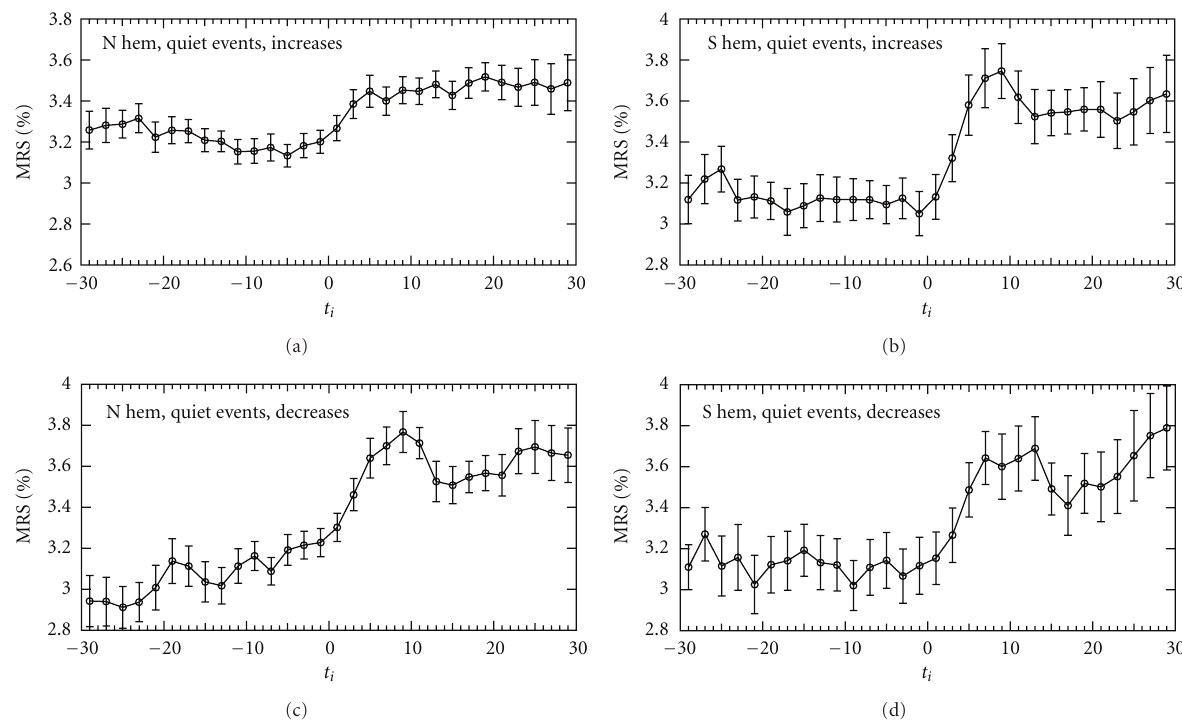
Figure 1: MRS as a function of the scan time, t i , for Quiet events: (a) NH Is; (b) SH Is; (c) NH Ds; (d) SH Ds.